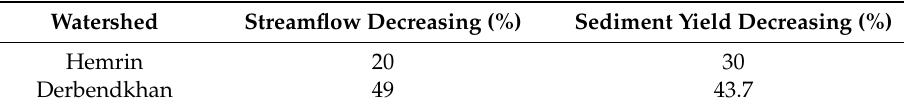
Table 4. Impact of climate change on the simulated streamflow and sediment yield for the Hemrin and Derbendkhan Watersheds.